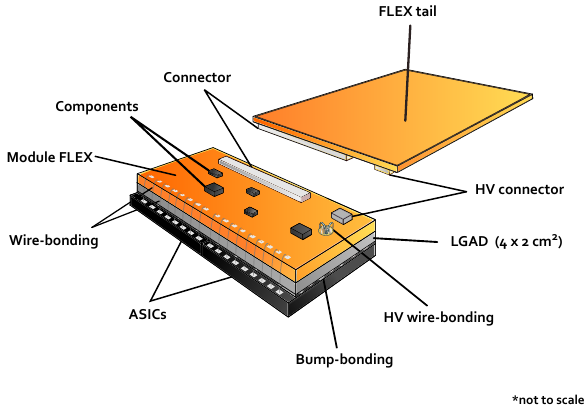
Fig. 4: View of an HGTD hybrid module equipped with its read-out flex cable tail [3].